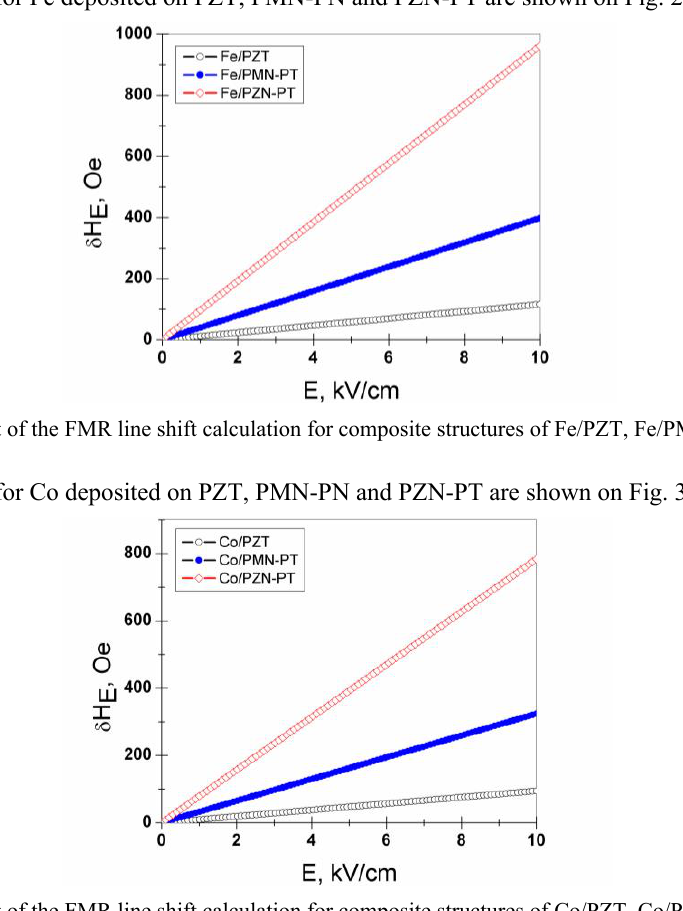
Fig. 3. Result of the FMR line shift calculation for composite structures of Co/PZT, Co/PMN-PT and